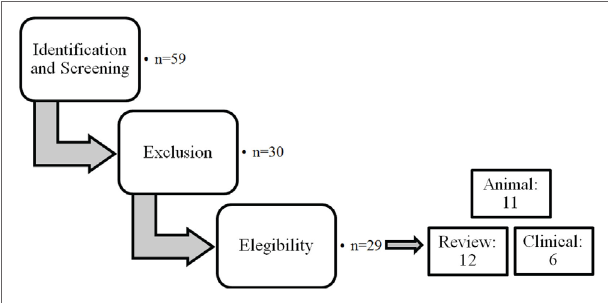
FigURe 1 | Schematic representation of the selection procedure for the articles included.